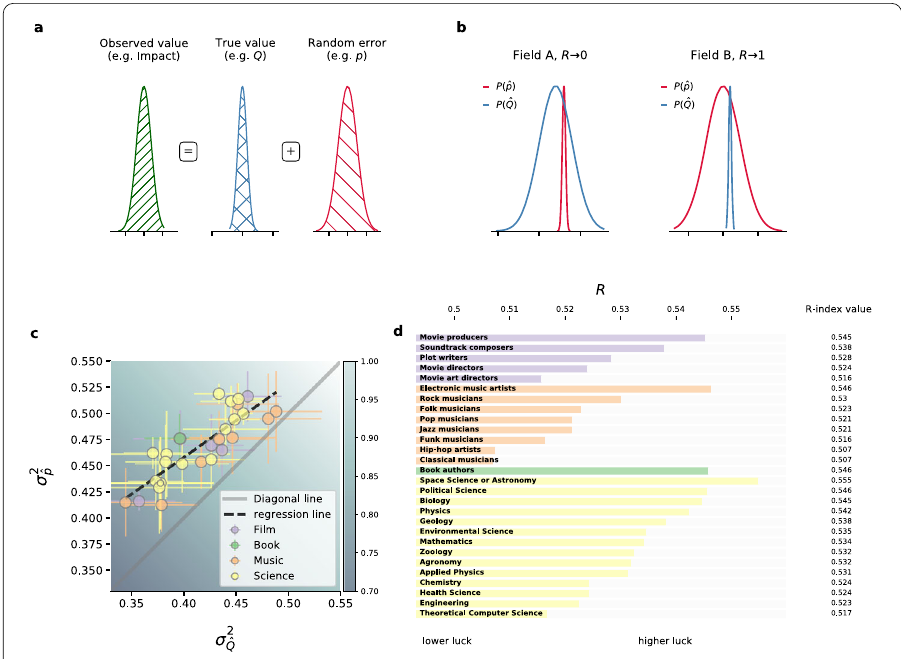
Figure 2 Fluctuations of impact, luck and Q . ( a ) According to the classical test theory, the normal distribution of an observed variable (green in the example) can be decomposed as the sum of the distributions of the true score (blue) and the error term (red). ( b ) Distribution of ˆ p and of ˆ Q for two different, fictional fields. In